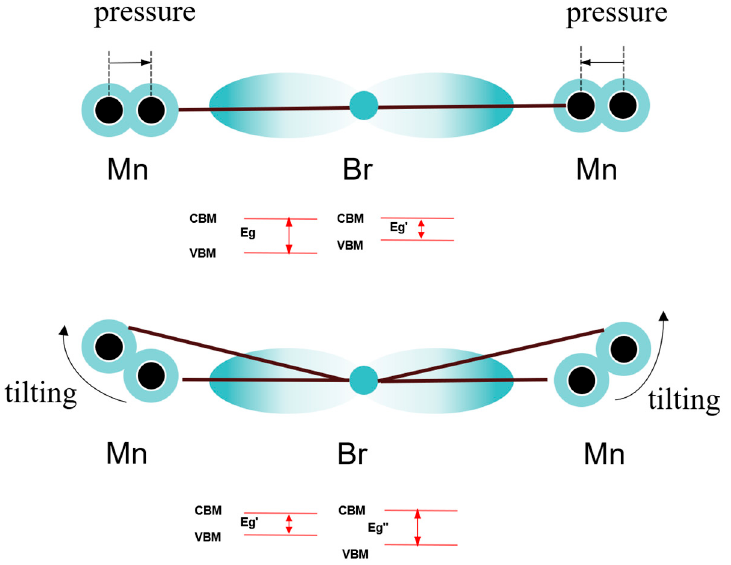
Scheme 1. Schematic diagram of the mechanism of pressure regulating the band gap of Mn-doped CsPbBr 3